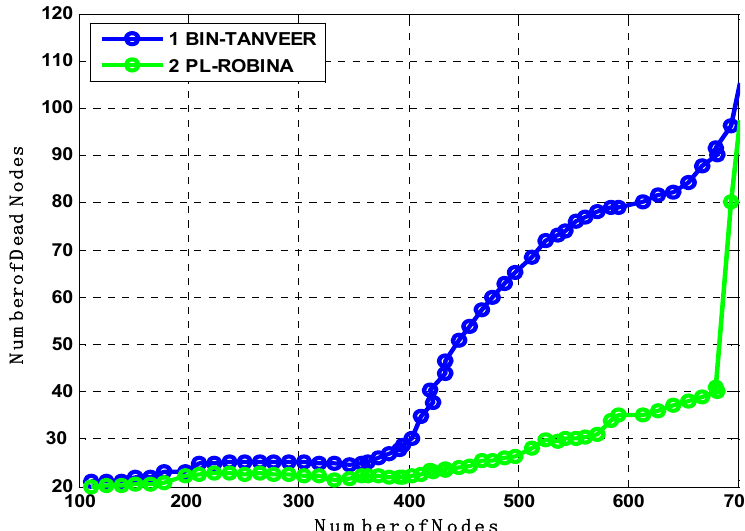
Figure 16. Analysis of the number of dead nodes compared with BIN-TANVEER and PL-ROBINA.